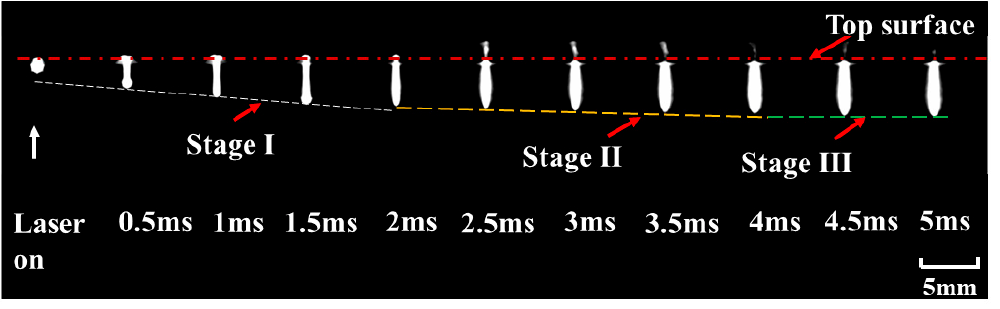
Figure 8. Keyhole evolution with the pulse width of 5 ms during single-pulse laser drilling at a peak power of 500 W.